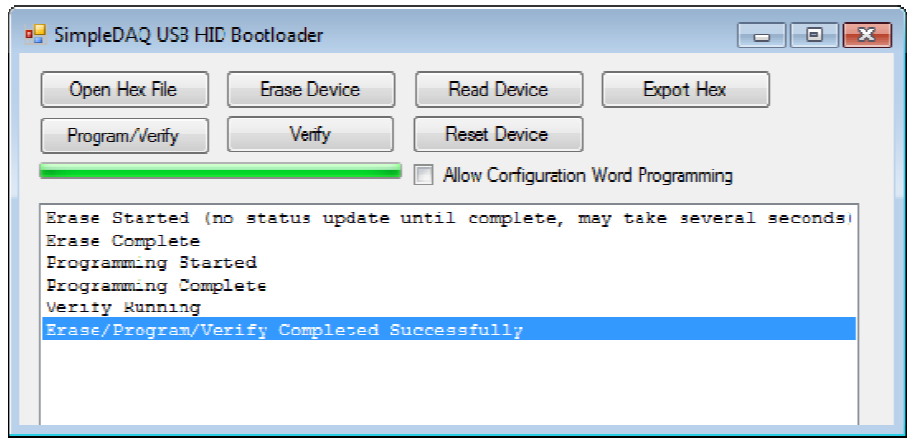
Figure 7. SimpleDAQ USB HID Bootloader PC